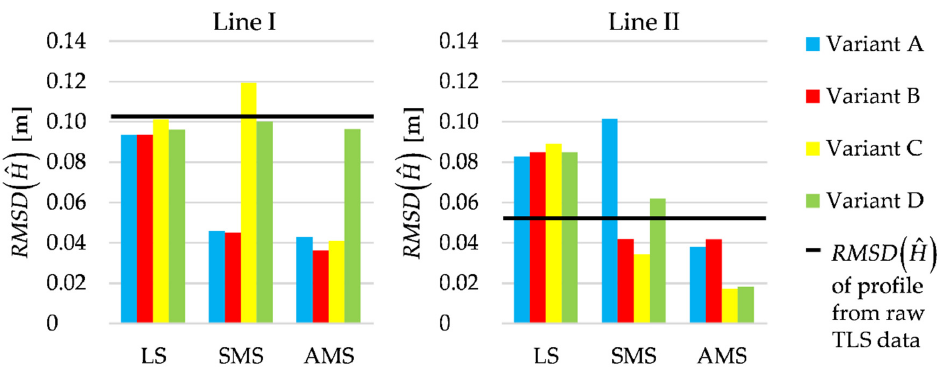
Figure 10. Lines I and II; accuracy of the estimated profiles compared to accuracy of the profile obtained from raw TLS data. Table 2. Maximum, mean and median of ˆ j j H H − for lines I and II.